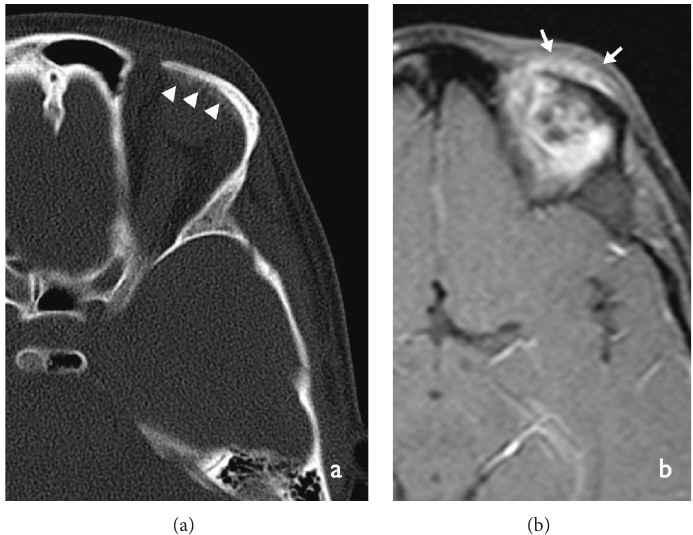
Figure 8: Axial noncontrast enhanced CT section in bone window projection (a) showing periosteal reaction exerted by the lesion on the superior orbital ridge seen as amorphous density. Contrast-enhanced sagittal T1-weighted MRI image (b) showing an amorphous area of enhancement of the